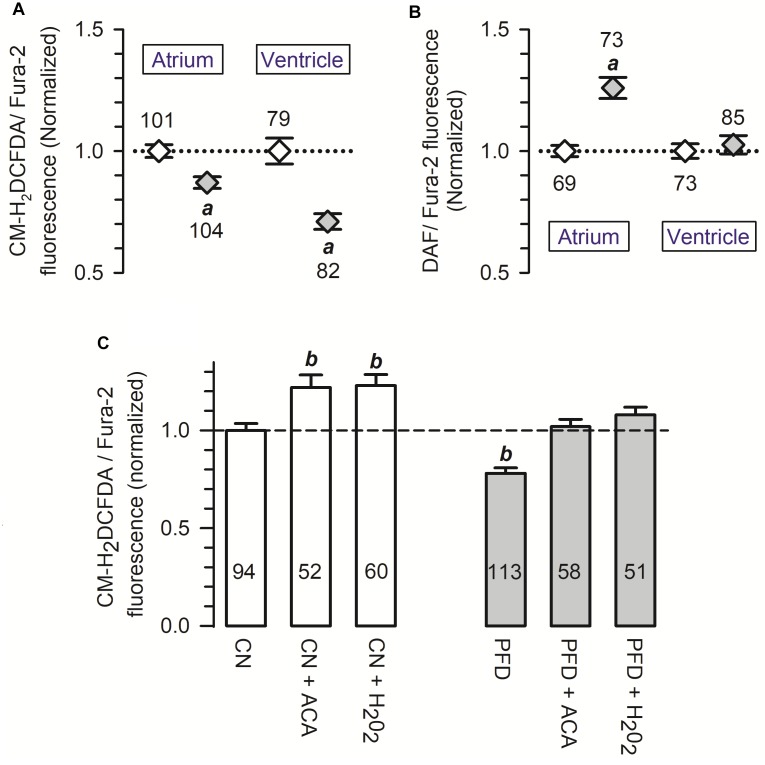
Pirfenidone regulates the production of both ROS and NO. (A,B) Cardiomyocytes were loaded with a 1:1 mixture of Fura-2 and a fluorescence sensor for either ROS (A) or NO (B). For each cell, the fluorescent signal of the sensor was divided by that of Fura-2 (used as a loading control), and then the resulting ratio was normalized to the respective mean value of control cells. (C) Average ROS production measured as in (A) (CN, PFD), except that some determinations were performed in the presence of either acetaldehyde (ACA) or H2O2 (200 μM, 30 min). Open and gray symbols/bars indicate control and PFD-treated treated cells, respectively. ap < 0.001, compared with the corresponding control. bp < 0.005, compared with CN.